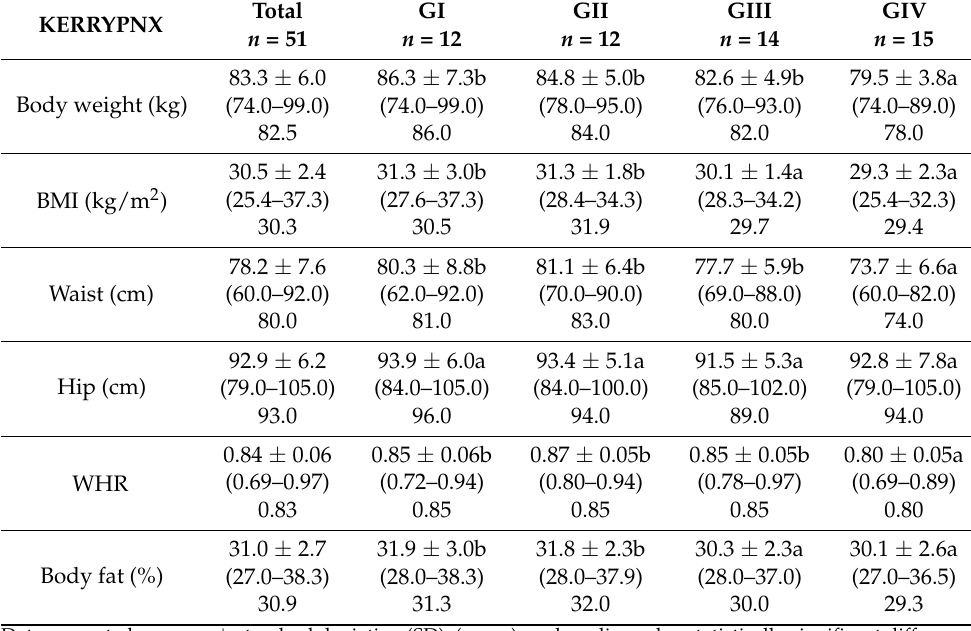
Table 3. The anthropometric parameters of the subjects six months after therapy.